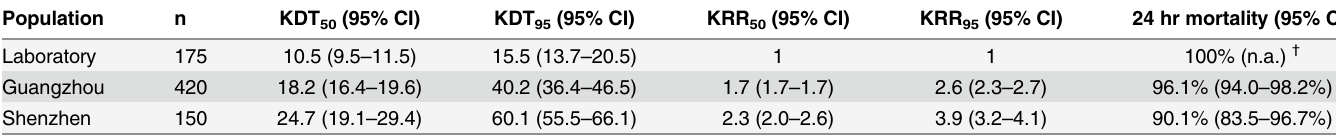
Table 2. Knockdown time and mortality rate of Aedes albopictus populations from southern China using the standard WHO tube susceptibility bio- assay against 0.05% deltamethrin. Population